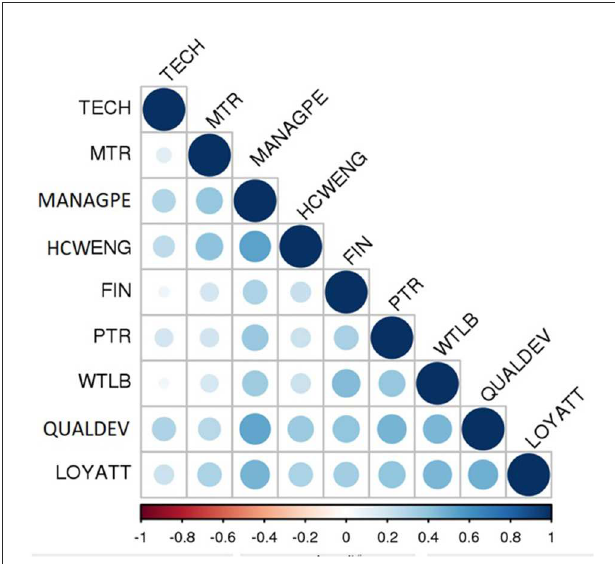
FIGURE6 The resulting strategic map of Palestinian HCWs based on the path analysis of BSC-HCW1 factors (source: own elaboration). The numbers on the straight lines reflect the standardized regression weights (total effect). The numbers on the curved lines represent the correlations between experience factors. MANAG-PE, management performance evaluation; HCW-ENG, health care workers’ engagement; FIN, financial incentives; QUALDEV, quality and development; TECH, technology; WTLB, workload time-life balance; MTR, HCWs trusting their managers; PTR, perceived patient respect and trust attitudes toward health care workers; LOY-ATT, loyalty attitudes.